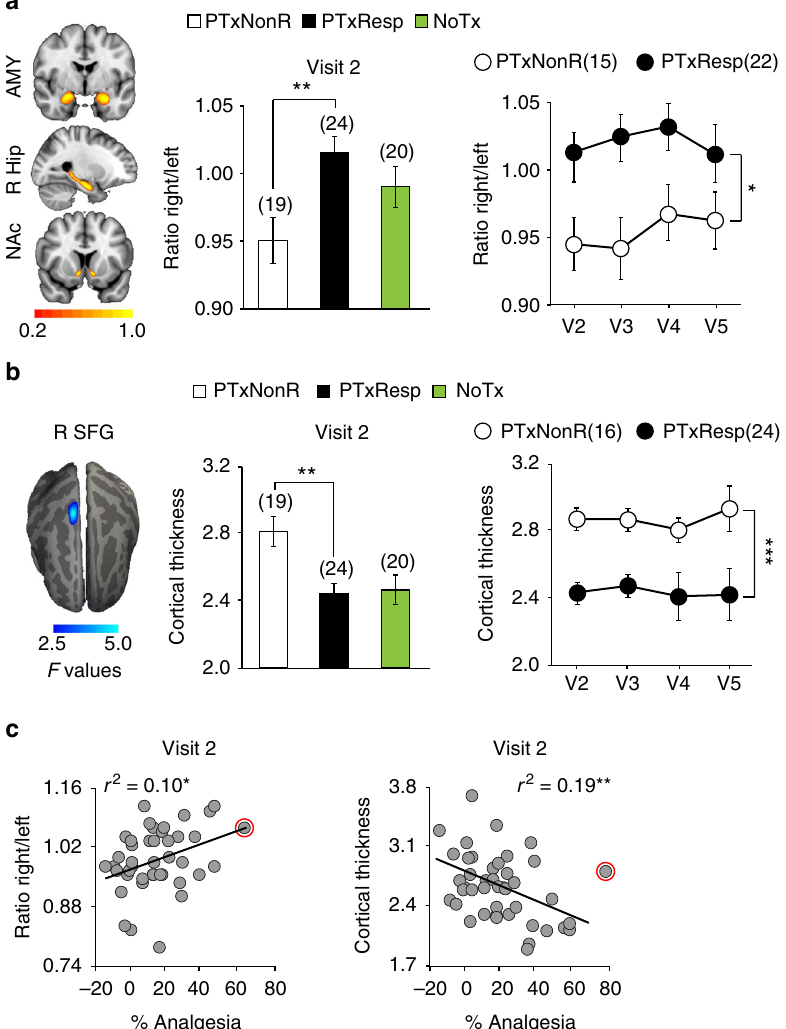
Fig. 3 Placebo pill response is predetermined by subcortical limbic volume asymmetry and sensorimotor cortex thickness. a Heat maps display overlap of automated segmentation for nucleus accumbens (NAc), right hippocampus (R Hip), and amygdala (AMY) across all patients. The placebo pill responders displayed a rightward asymmetry in overall volume of these three subcortical limbic structures after controlling for peripheral gray matter volume, age, and sex at visit 2. The placebo group-dependent asymmetry was observed at all 4 visits/scans. b Whole-brain neocortical vertex-wise contrast indicated thicker sensorimotor, right superior frontal gyrus (R SFG), in PTxNonR. This effect was consistent across all 4 visits/scans. c These anatomical properties correlated with the magnitude of the response. All post hoc comparisons were Bonferroni corrected for three comparisons: * p < 0.05; ** p < 0.01; *** p < 0.001. Error bars indicate SEM. The red circle marks an outlier on the magnitude of response and was excluded from the %analgesia correlation